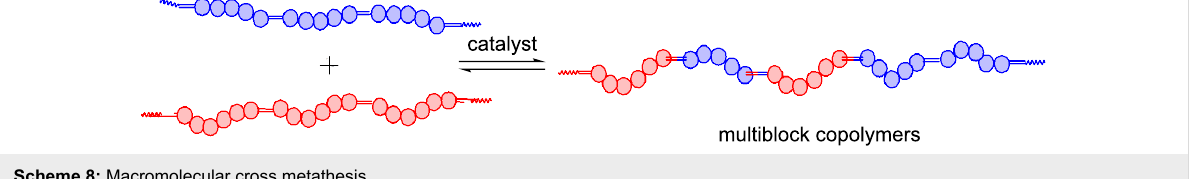
Scheme 8: Macromolecular cross metathesis.